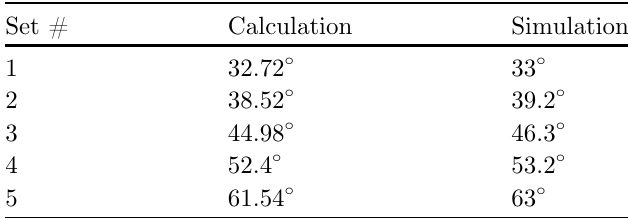
Fig. 8. Gain patterns of the SMRS antenna at 9GHz according to the caclulated surface reactance sets in Section 3. Table 3. Comparison of the calculated radiation angles and simulated radiation angles according to the set numbers at 9 GHz.